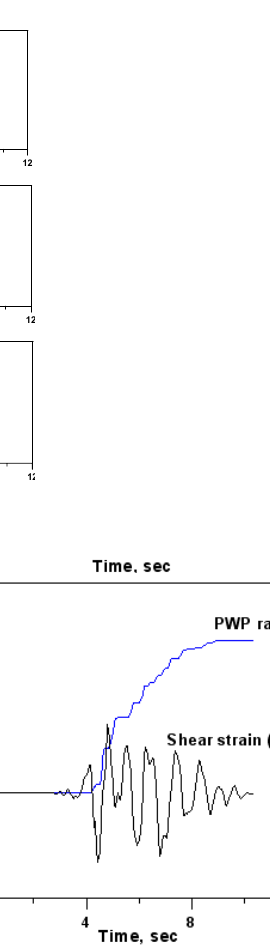
Fig. 20. Stress-strain history (a) for the layer with high probability to liquefy; PWP time histories at different ground level (b) ; PWP and Figure 20 shear strain time histories (c) for the layer with high probability to liquefy.